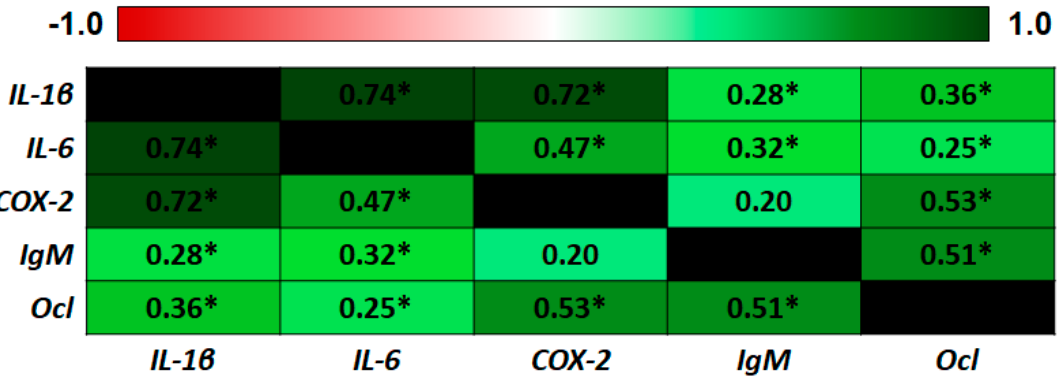
Figure 6. Correlation analysis of gene expression determined in samples after the ex vivo assay. Pearson product-moment coefficients between each pair of genes. Significant correlations are indicated with an *.